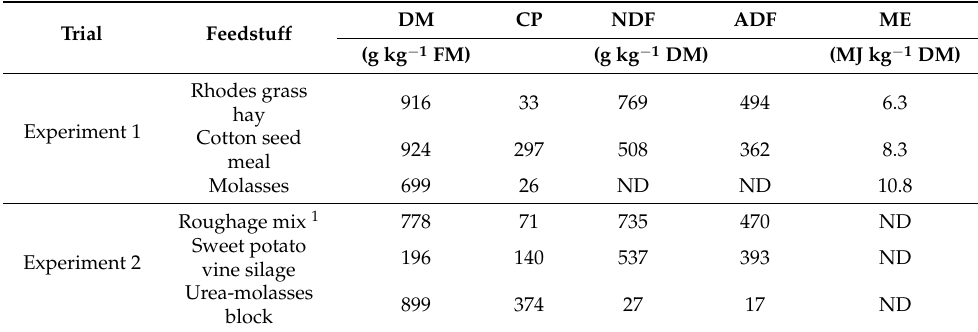
Table 1. Dry matter (DM), crude protein (CP), neutral detergent fiber (NDF), acid detergent fiber (ADF) and metabolizable energy (ME) concentrations of feedstuffs offered to cattle in feeding trials with steers (experiment 1) and heifers (experiment